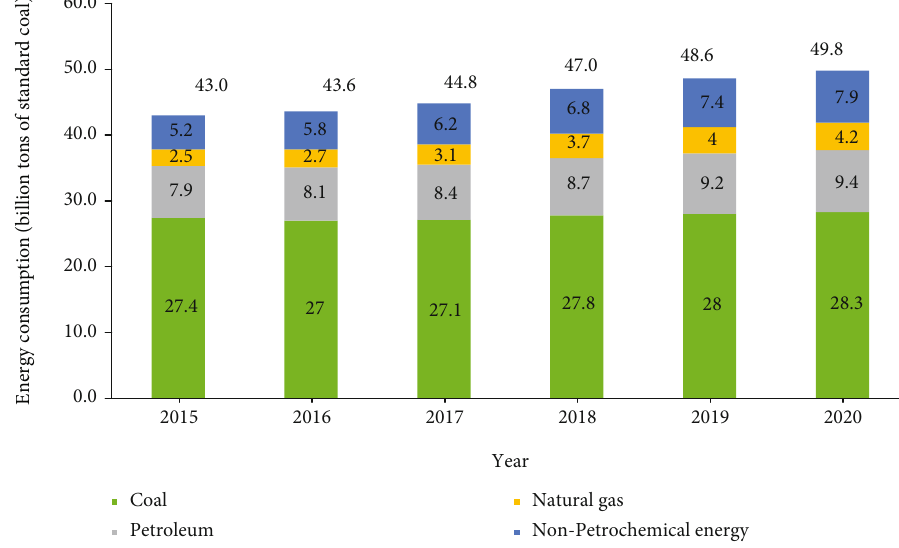
Figure 1: Evolution of energy consumption structure in China from 2015 to